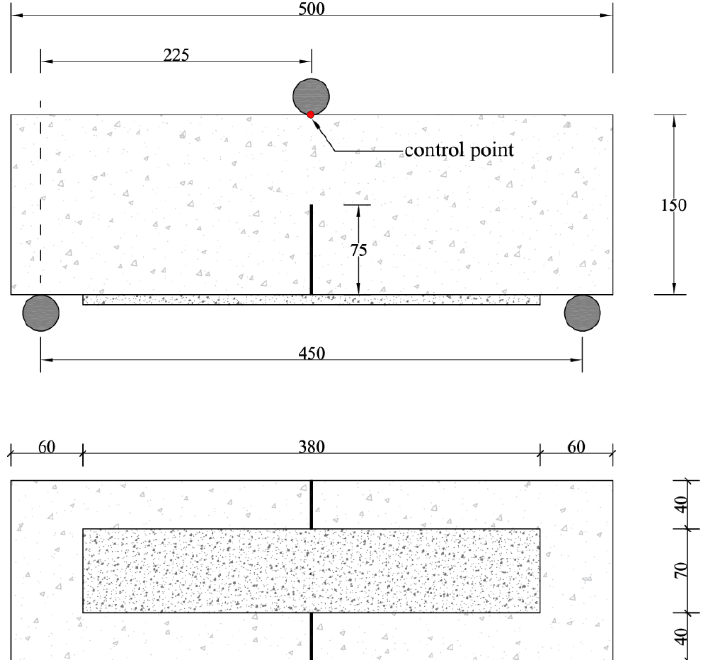
Figure 4. Final configuration of concrete beams with externally bonded PBO-FRCM sheet: front view